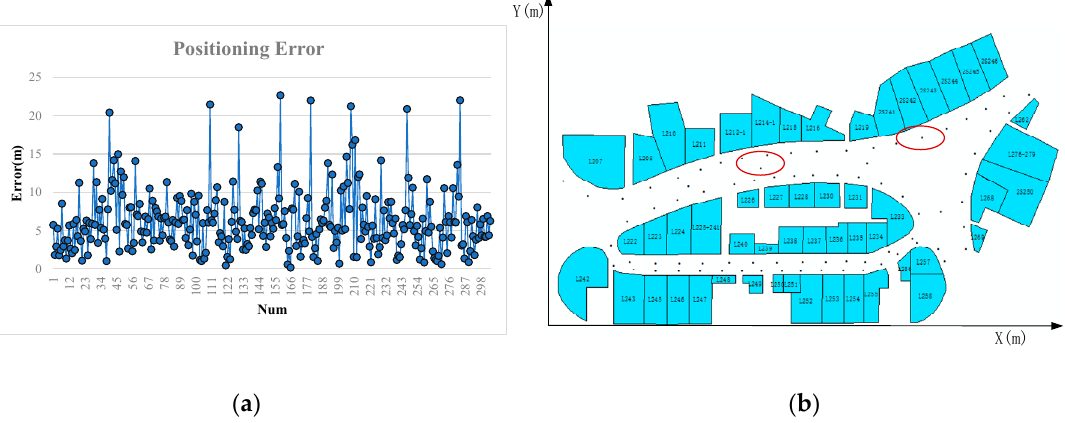
Figure 10. ( a ) Positioning error and ( b ) the location of the ambiguity fingerprints.